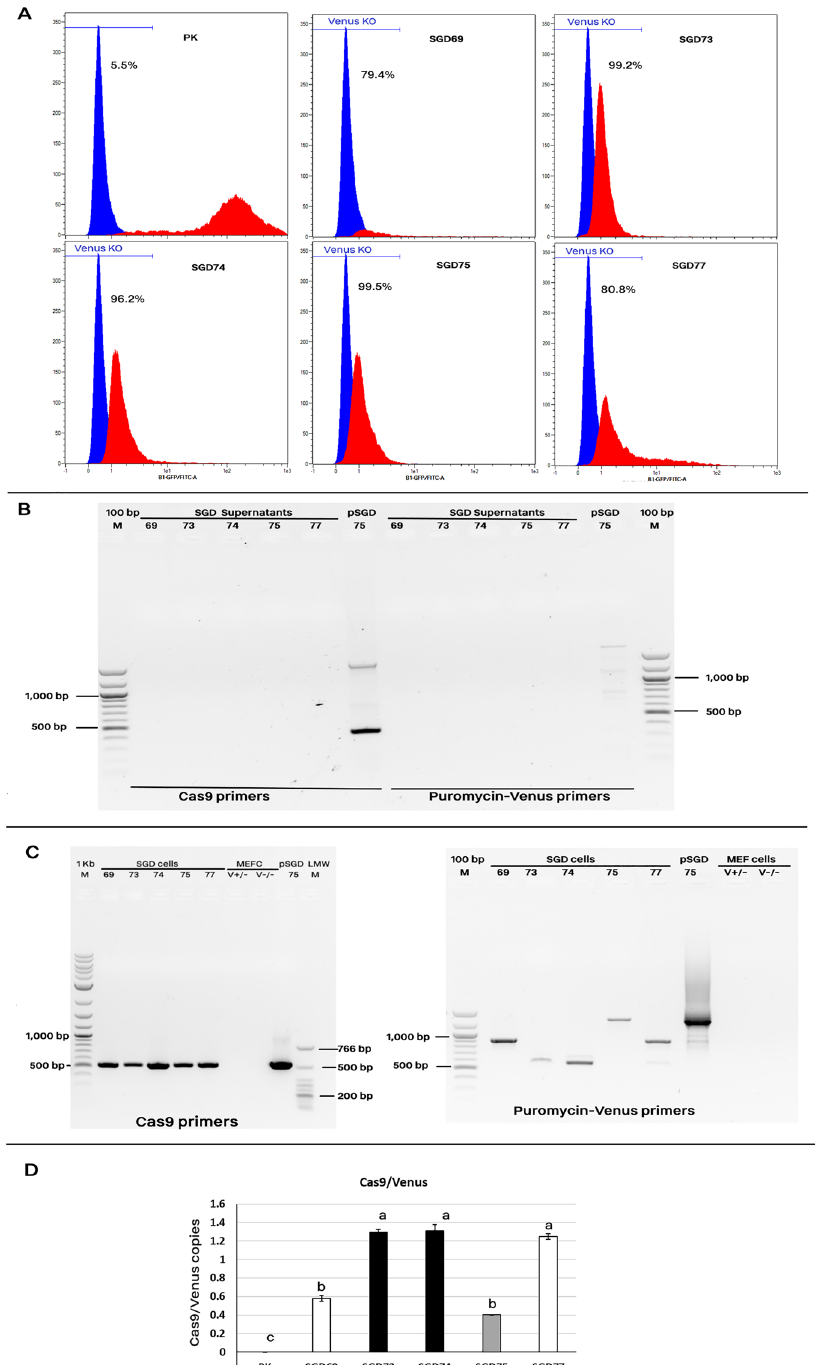
Figure 3. HDR-mediated Venus knock-out using various SGD constructs. The MEF cells carrying a single copy of Venus transgene were electrotransfected with pSGD plasmids. The pSGD75 plasmid which carried gRNA + 121 and induced NHEJ- mediated Venus knock-out was used as the transfection control. The electrotransfected cells were selected with puromycin for 105 days. ( A ) Results of FACS analysis. The Venus expression pattern of either PK or pSGD-electrotransfected cells are shown in red color. The MEF cells with no Venus transgene were considered as the negative control and was depicted in blue color. ( B ) and ( C ) End-point PCR using two sets of primer pairs on supernatants and genomic DNA of SGD groups, respectively. After 105 days, pSGD-electroporated cells were DNaseI-treated. A fraction of supernatants was used for PCR to assess plasmid carry-over from the initial step of electroporation. Genomic DNA was extracted from cell pellets and used for PCR. Two sets of primers were used to amplify the puromycin-Venus which was detectable only in the HDR events although with different lengths of amplicons. Moreover, Cas9 primers were used for detection of the Cas9 transgene. This primer set produced a same band of PCR product in all SGD groups. ( C ) Digital PCR assays specific for detection of Venus and Cas9 sequences. Two sets of primer–probe assays were used to detect the copy number of Venus and Cas9 genes and the rate of Cas9 copies to Venus copies was